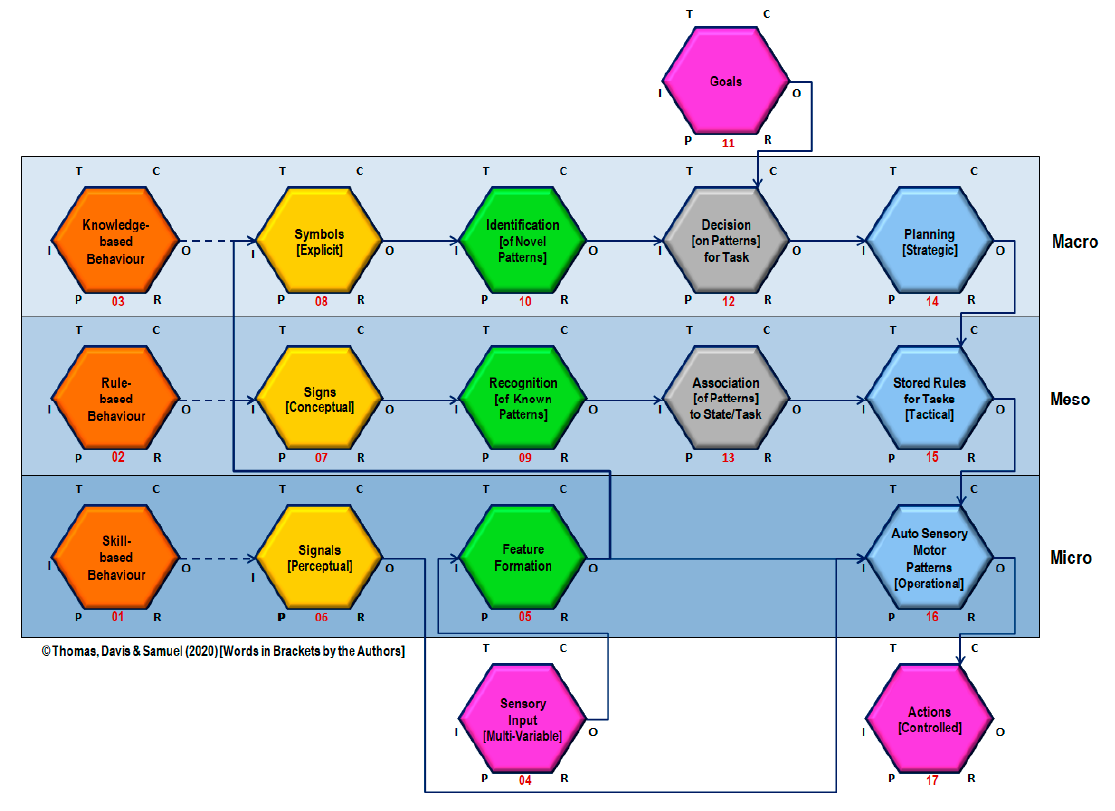
Figure 6. Skill-Rule-Knowledge Framework of Rasmussen, Interpreted using the FRAMED-IN-FRAM ® Diagram.